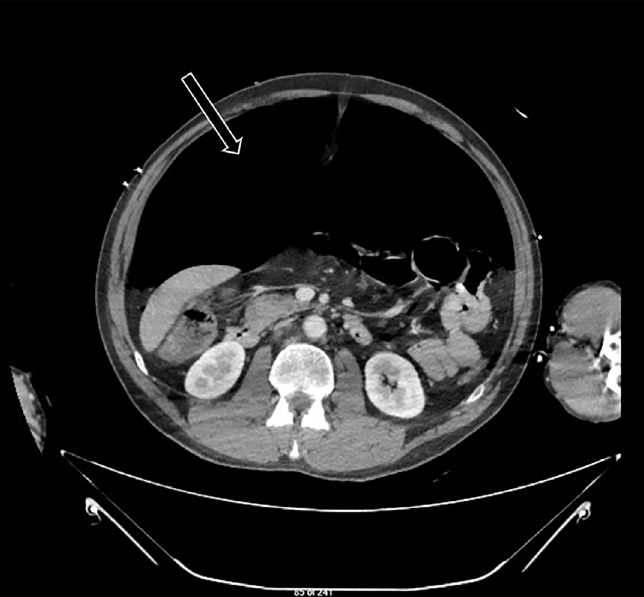
Image 2. Computed tomography of the abdomen with intra - venous contrast at the level of the inferior tip of the liver and kidneys showing large pneumoperitoneum, as noted by arrow, with tension physiology.